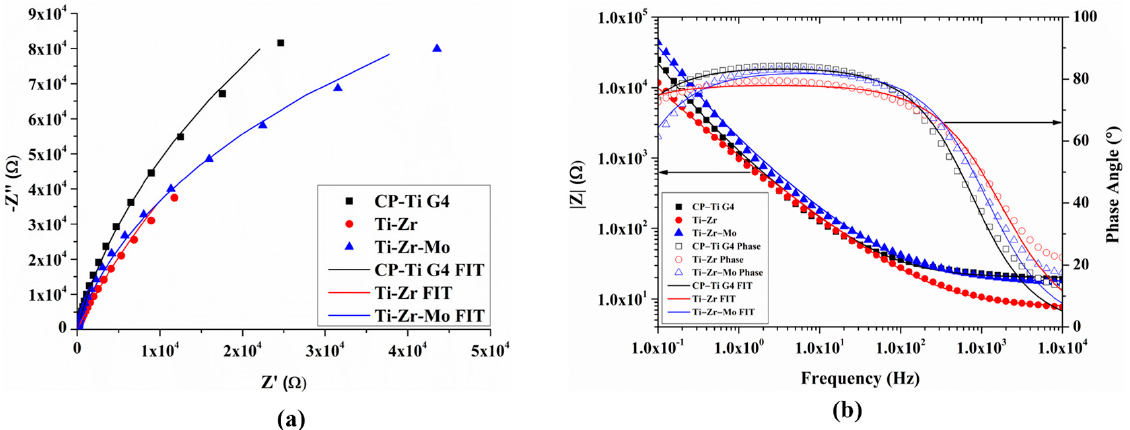
Figure 6. ( a ) the Nyquist diagram and ( b ) the Bode diagram.